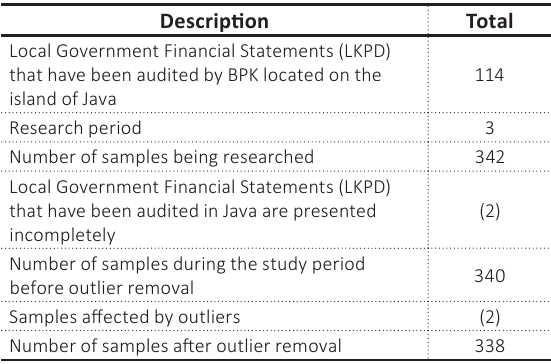
Table 1. Research sample